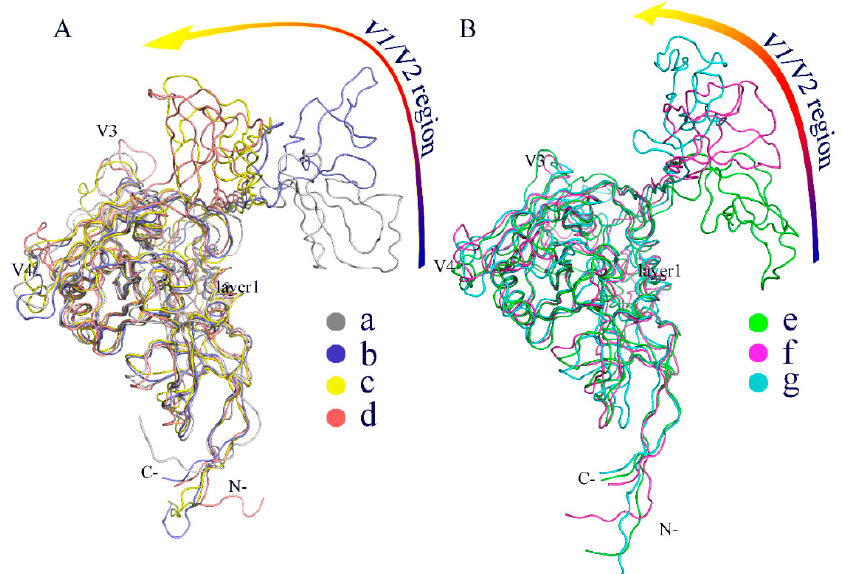
Figure 7. Backbone superimposition of the representative structures/substates extracted from the free energy basins/minima in the constructed FELs for ( A ) the CD4-free gp120 (“a” to “d”) and ( B ) the CD4-complexed gp120 (“e” to “g”).